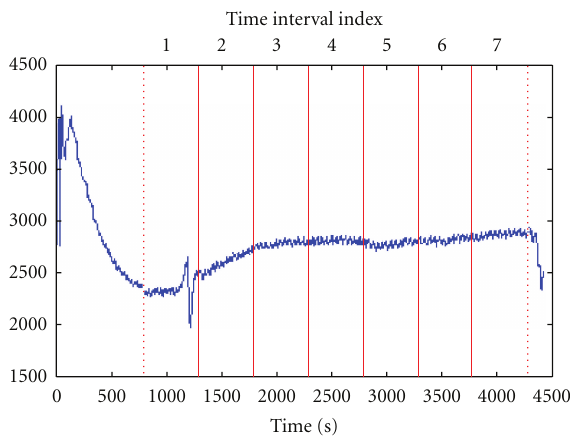
Figure 7: Amplitude of the heartbeat signal. The time intervals used in the monitoring are also pointed out.